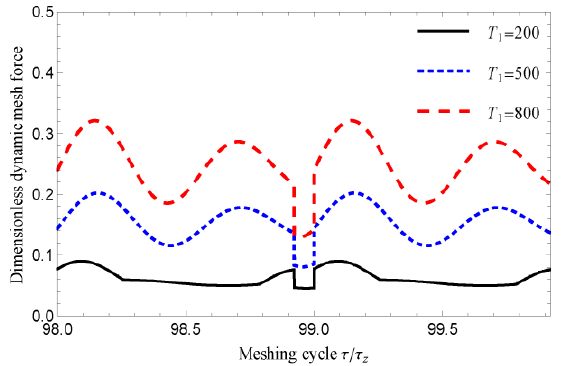
Figure 23. Total dynamic mesh force under different 𝑇 1 .